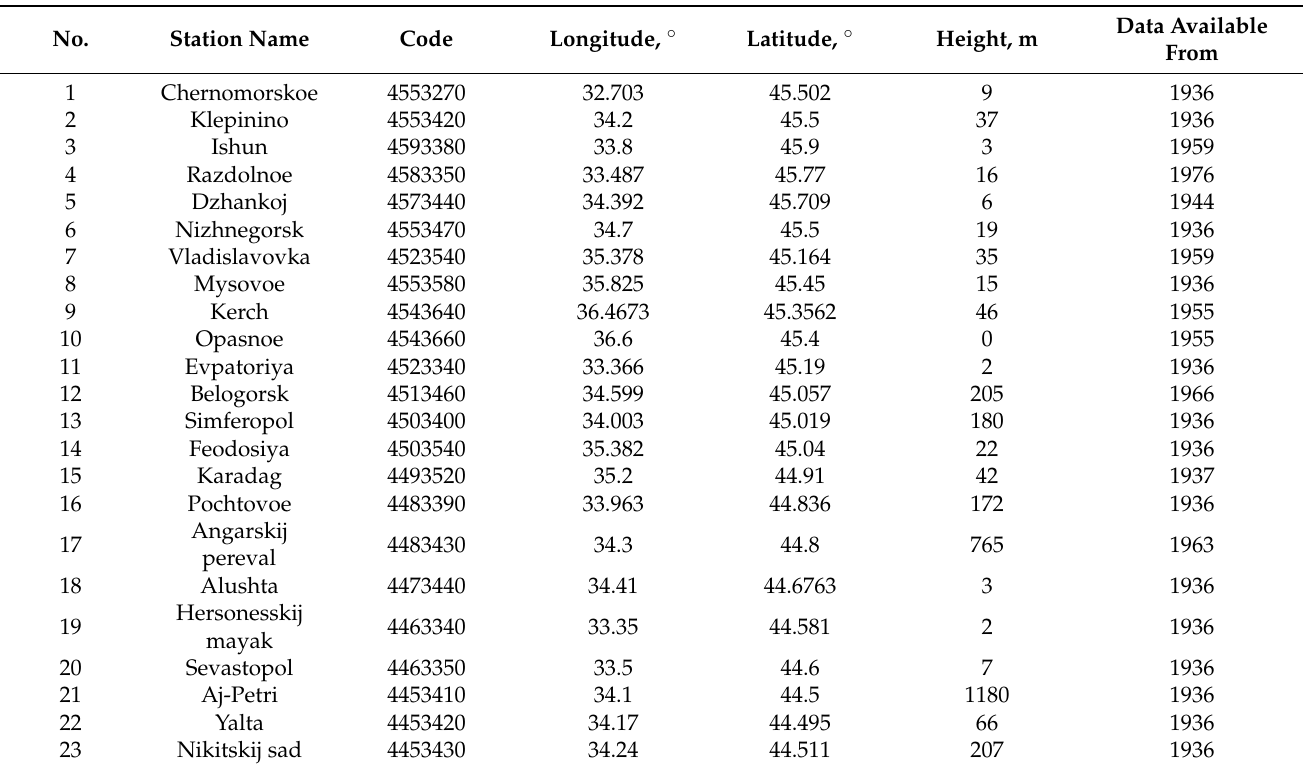
Table 1. List of meteorological stations of the Crimean